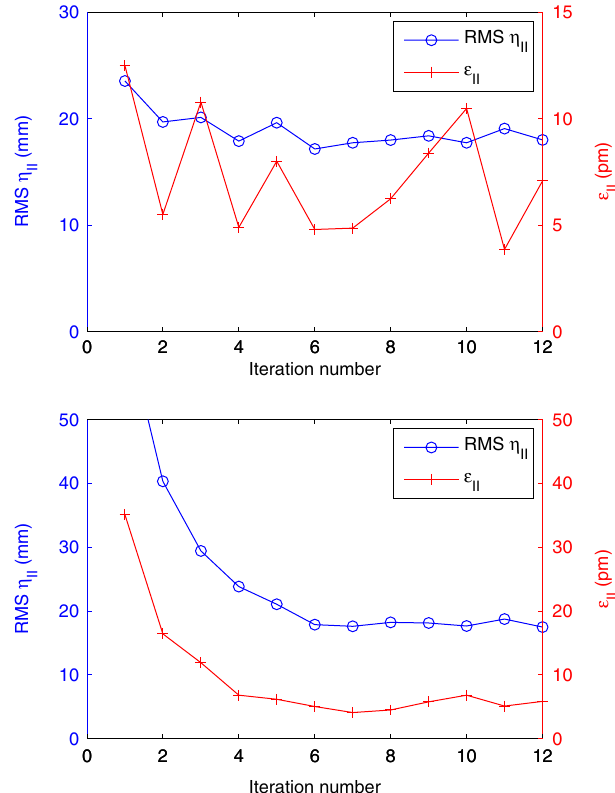
FIG. 15. Results from simulation of iterating a mode II dis- persion correction for tuning the mode II emittance. Top: with a scaling factor of 1 applied to the computed changes in skew quadrupole strengths, there are significant fluctuations in the mode II emittance in successive iteration. Bottom: with a scaling factor of 0.4, the fluctuations are smoothed out, and the emit- tance (and dispersion) converge to some final values. The same magnitude of machine errors was applied as used in the simu- lations described in Sec. III D. Note that the same seed of random errors was used to generate both top and bottom